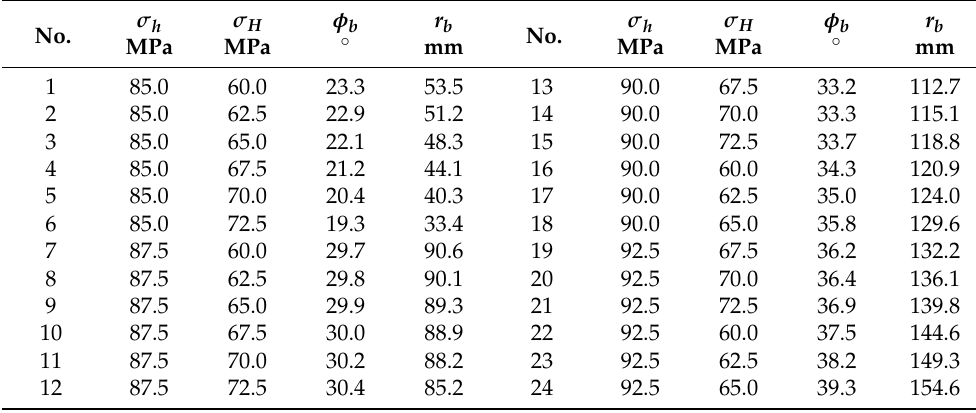
Table 2. Result of the shape of wellbore breakouts r b and φ b by